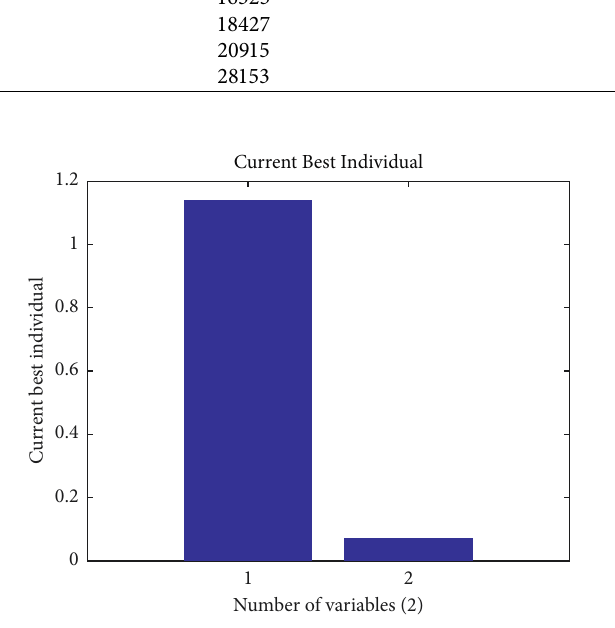
Figure 4: Optimal value parameters. Table 6: Simulation results of wind power installed capacity in China.